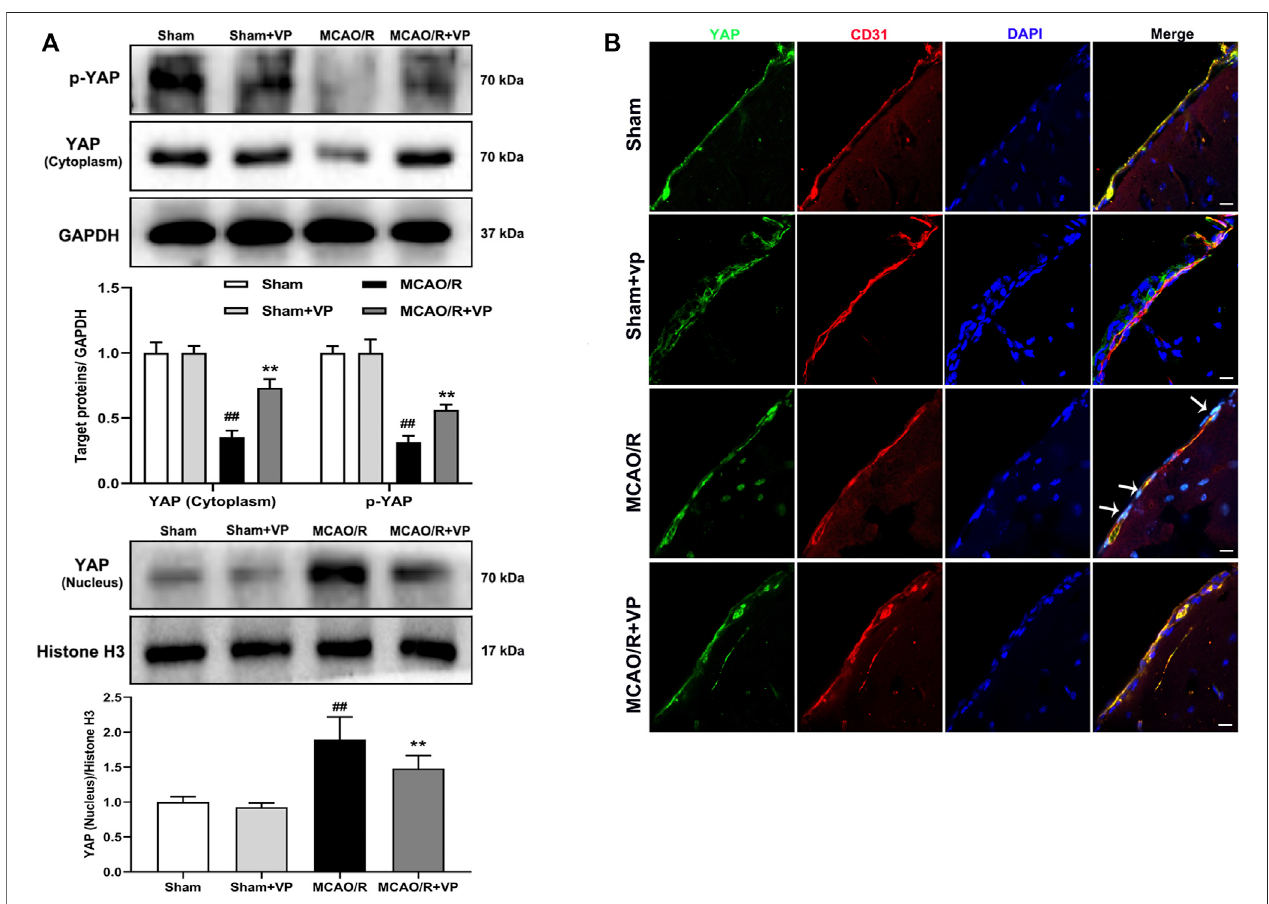
FIGURE 2 | Effects of VP treatment on YAP/p-YAP expression levels following MCAO/R injury in mice. Mice were subjected to 1 h of ischemia and 24 h of reperfusion. (A) Representativewesternblotsandquantitativeanalysesoftheexpressionlevelsofp-YAP,YAP(cytoplasm),andYAP(nucleus) invivo . (B) Representative microscopic images of YAP (green), based on immuno fl uorescence analyses. DAPI-stained nuclei are depicted in blue. The white arrow represents the number of YAP protein into the nucleus. Data are expressed as the mean ± SD, n (cid:1) 6. ## p < 0.01 vs . Sham group, ** p < 0.01 vs . MCAO/R group. Scale bar (cid:1) 50 µm.